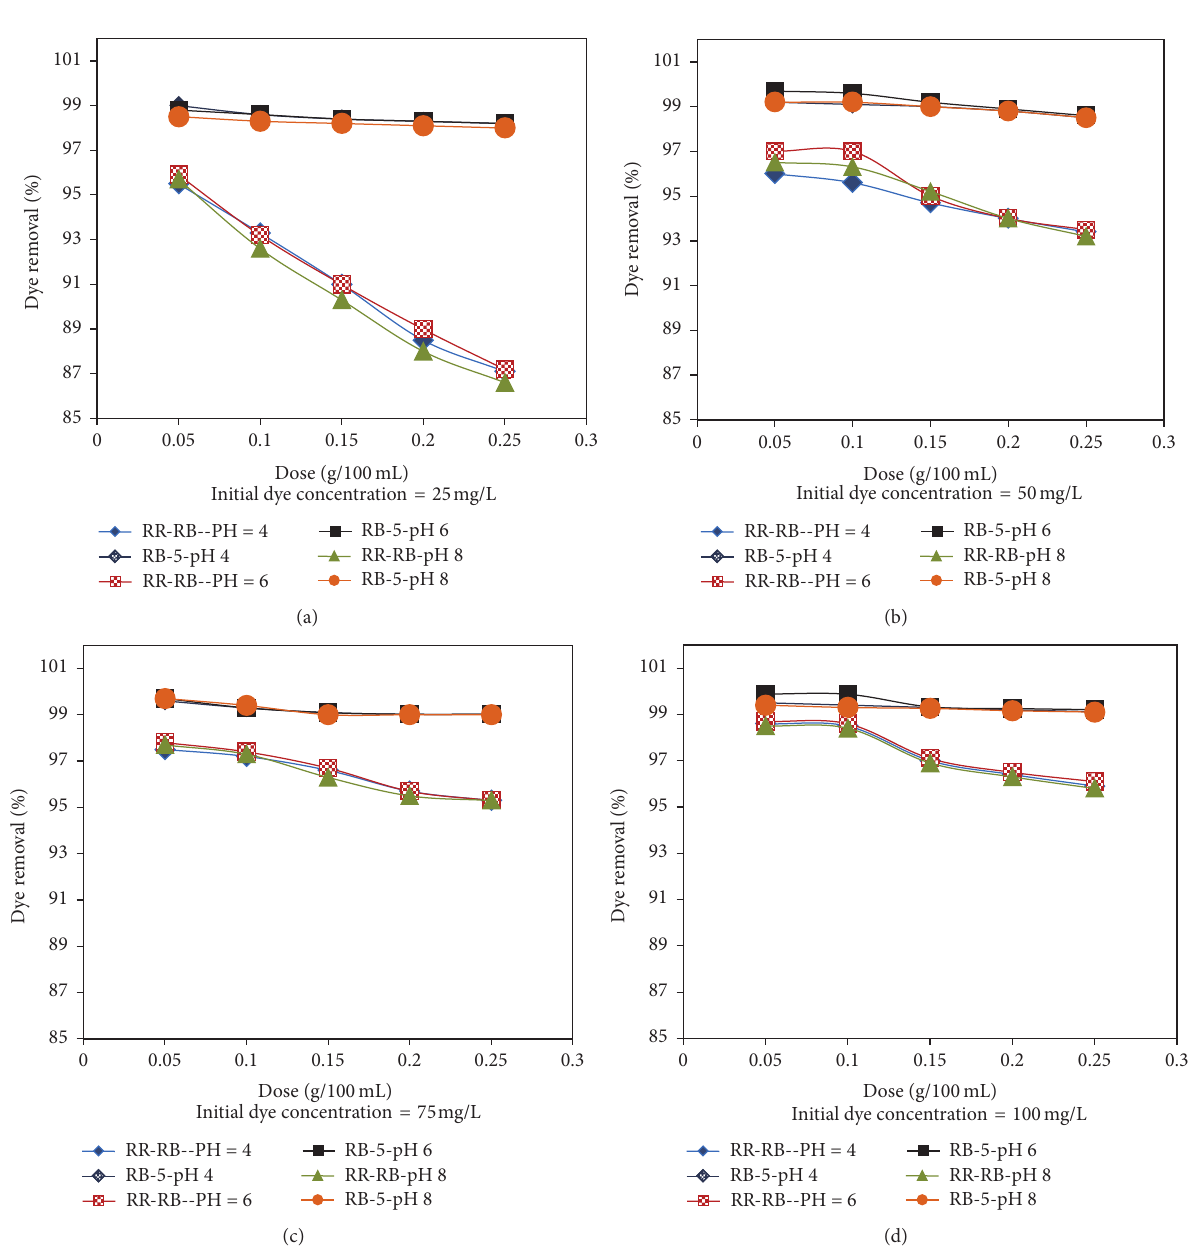
Figure 8: Effect of different adsorbent dosages in binary system with (a) 25 mg/L initial concentrations of RR-RB and RB-5, (b) 50 mg/L initial concentrations of RR-RB and RB-5, (c) 75 mg/L initial concentrations of RR-RB and RB-5, and (d) 100mg/L initial concentrations of RR-RB and RB-5 (temperature = 25 ∘ C, agitation speed = 200rpm, and adsorption time = 4 hr.).